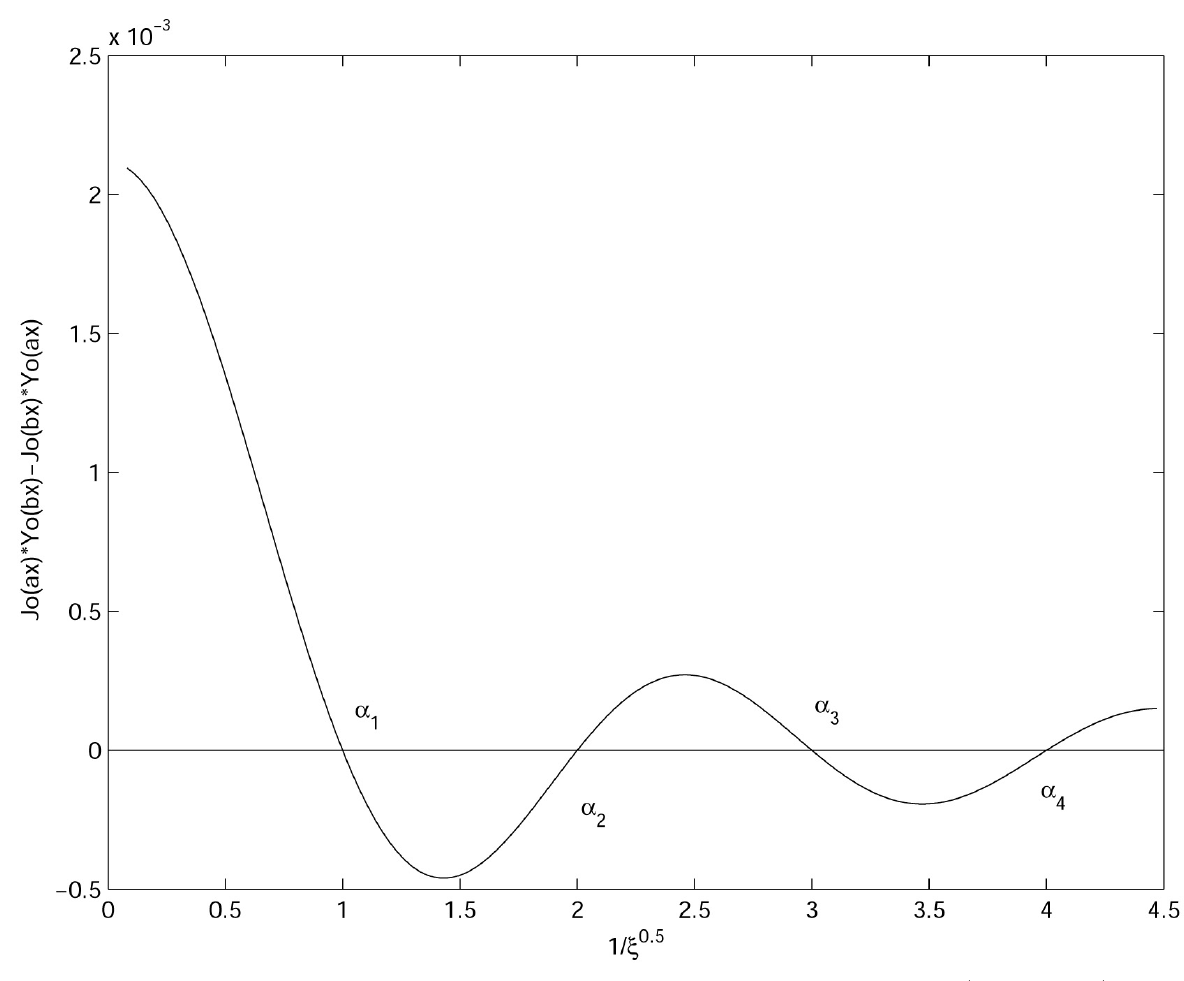
(cid:114) (cid:114) 1 1 R a , b = R b , and ν ν